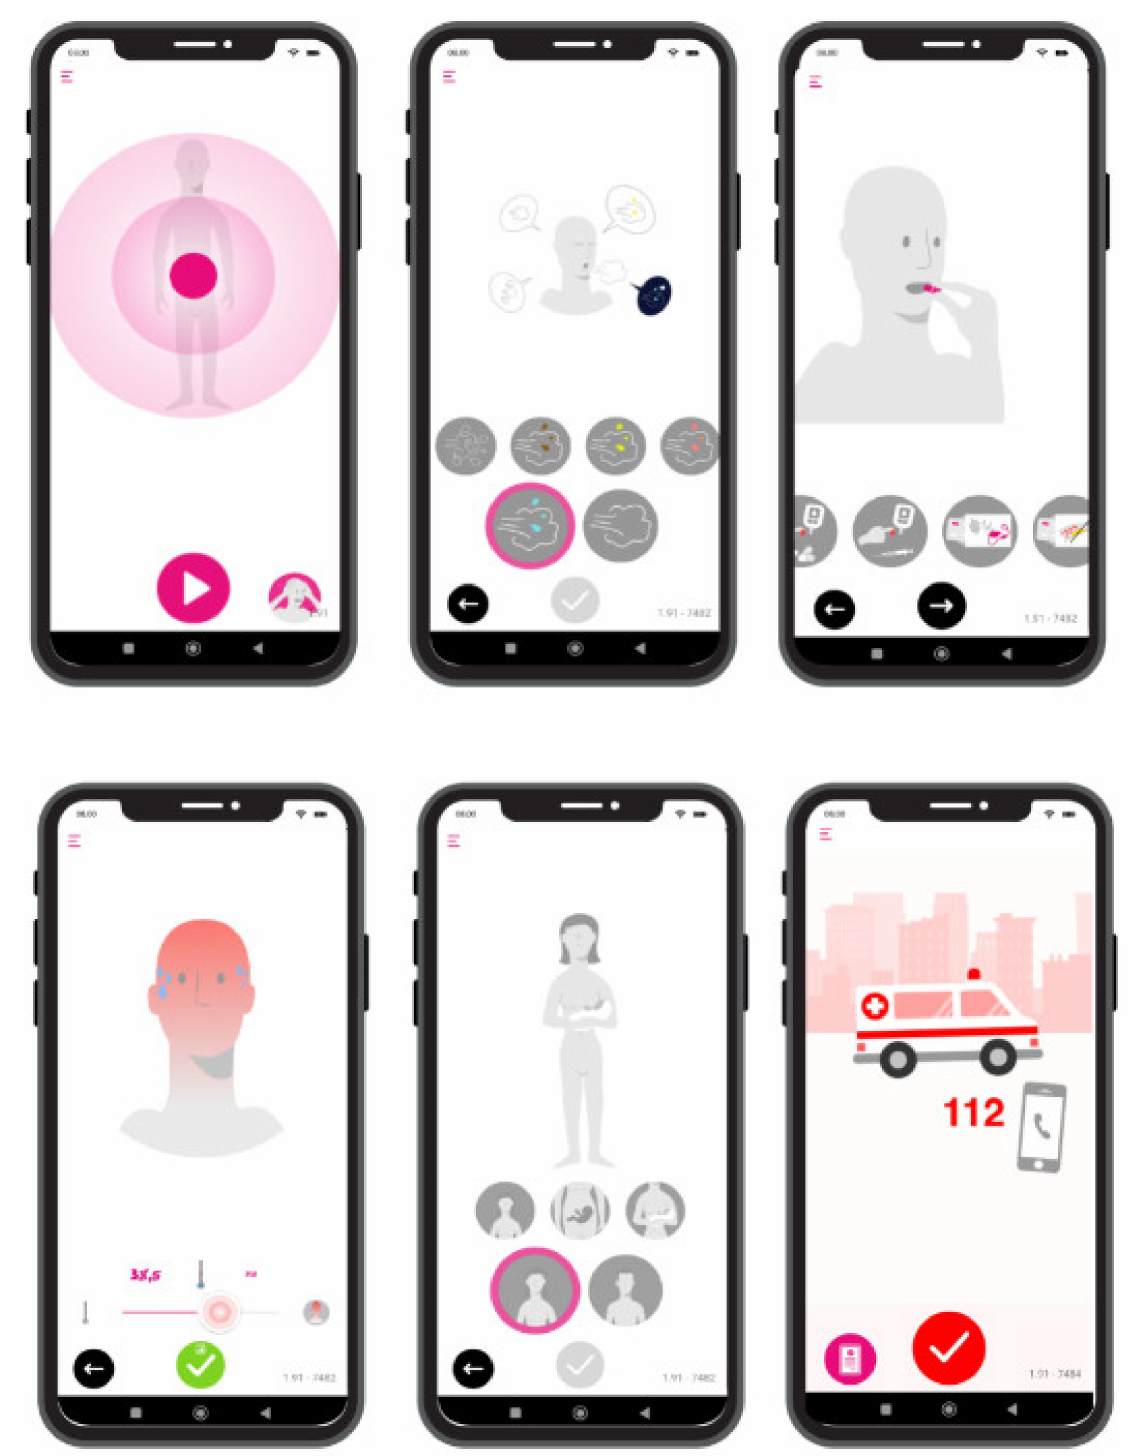
Figure 2. Sample of images shown on WW screens to interact with